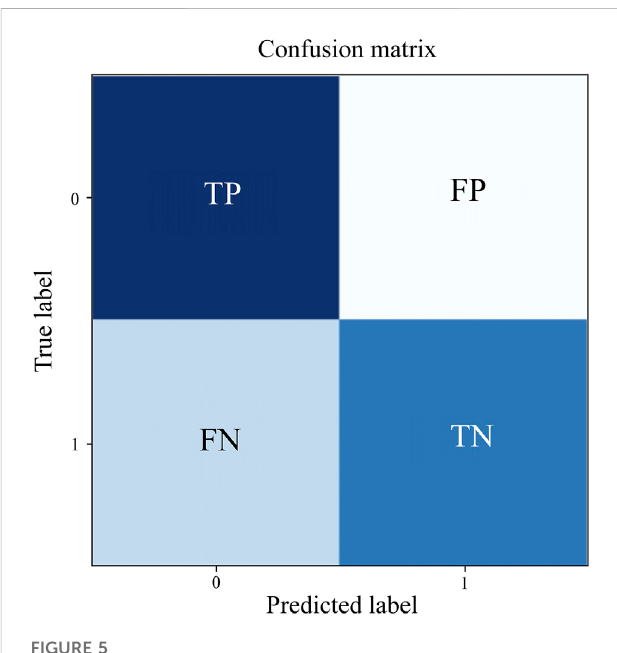
FIGURE 5 Diagram of the confusion